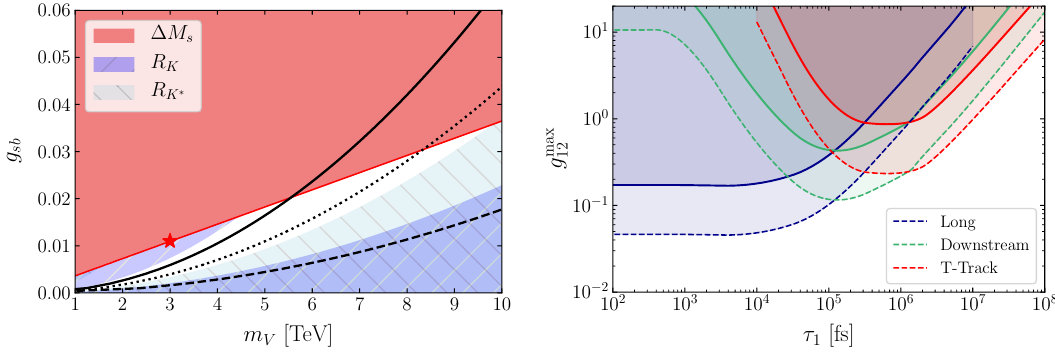
Figure 7 . (Left) The minimum vector-quarks coupling that could be tested with the search proposed in this work in the channel B + → K + 3 µ + 3 µ − . The light masses, couplings and lifetimes are assumed to be ( m 1 , m 2 ) = (1 . 0 , 2 . 5) GeV, g 12 = 1 . 5 and τ 1 = 1 ns. The solid, dotted and dashed lines show, respectively, the projected limits after Run 3, Run 4 and Run 5 of the LHCb experiment. (Right) The minimum vector-scalar coupling that could be tested with the same analysis, as a function of the lightest scalar lifetime. The same notation and benchmark masses as in the left panel are considered, as well as the mass and vector coupling marked with a star